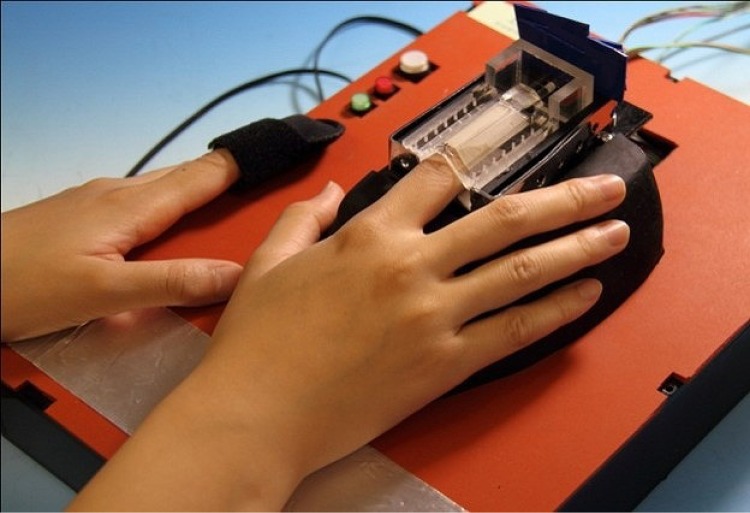
Photograph of the sensing system.